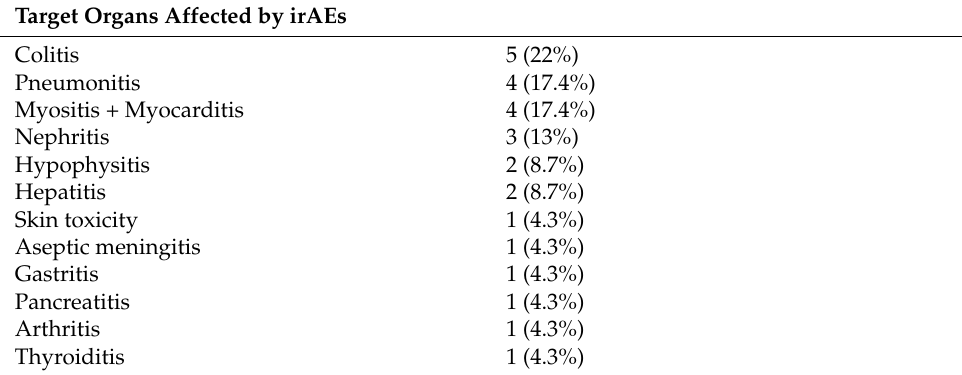
Table 2. Damaged organs due to irAE needing hospital admission.